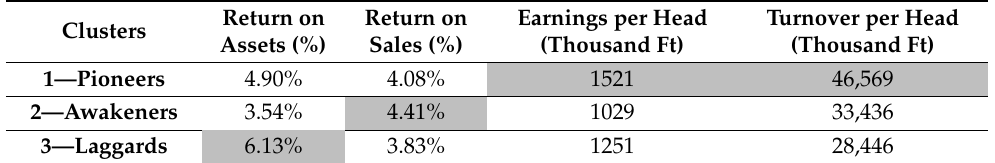
Table 7. Financial results of the clusters. Source: edited by authors.